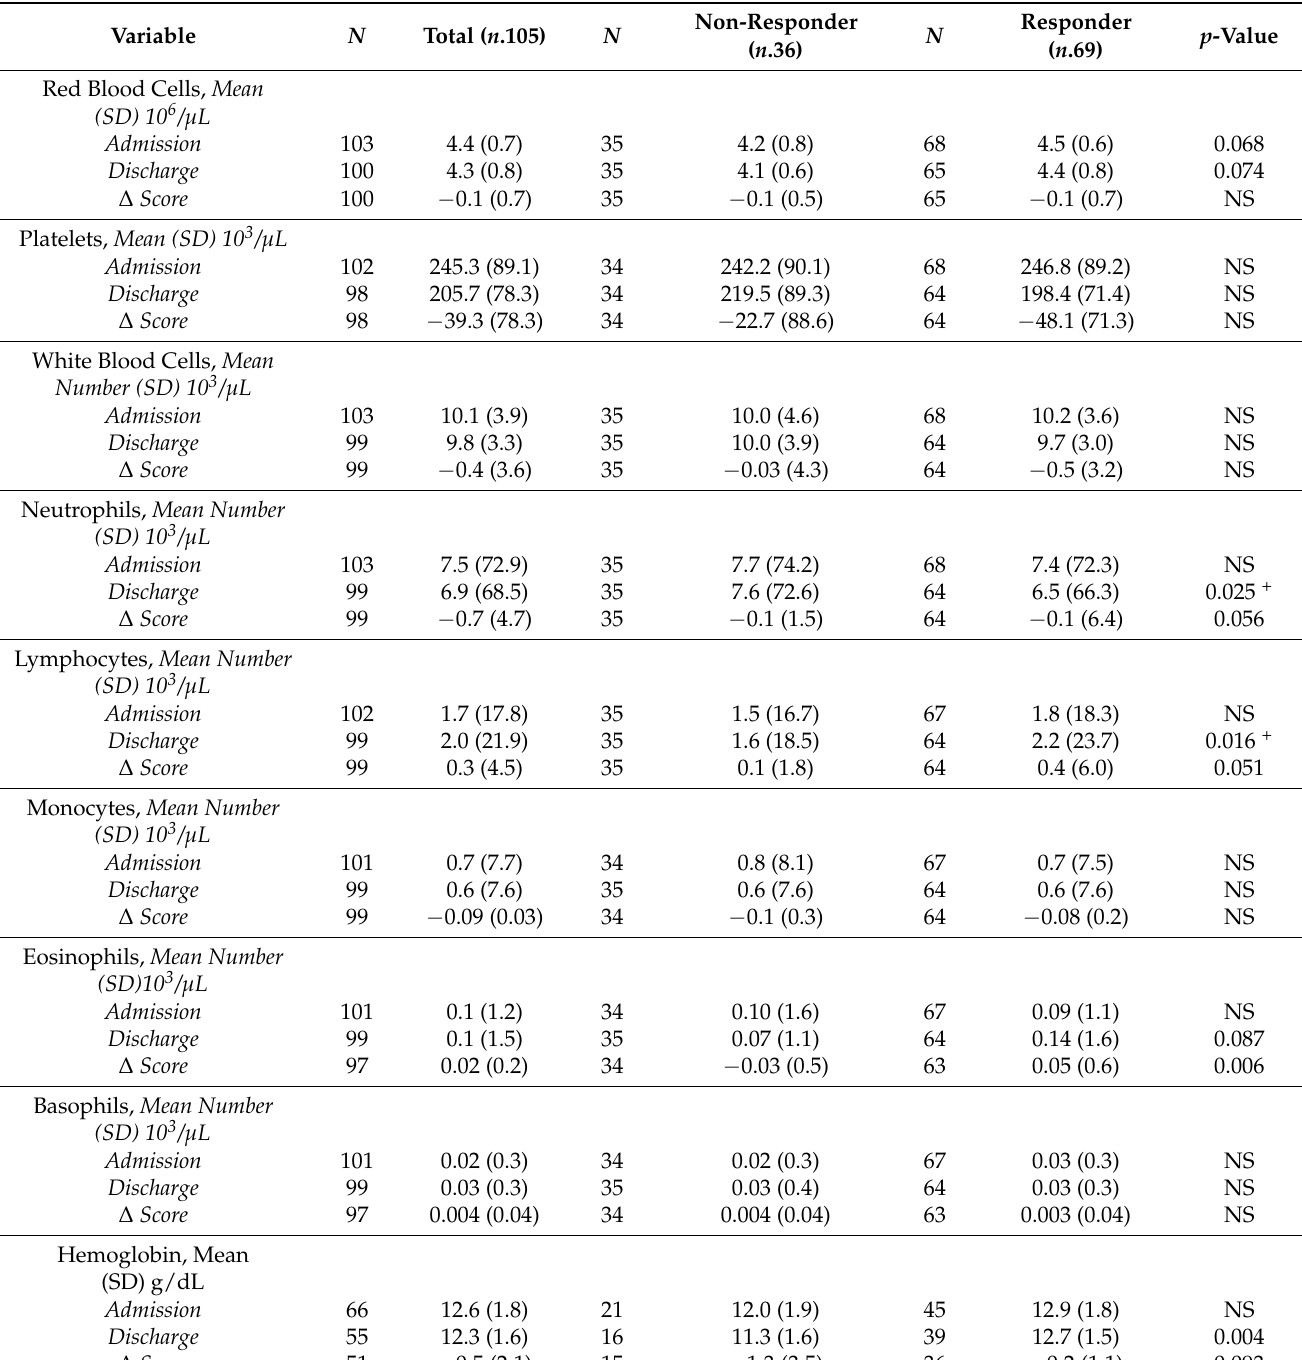
Table 2. Characteristics of blood test parameters in COPD patients by the response to